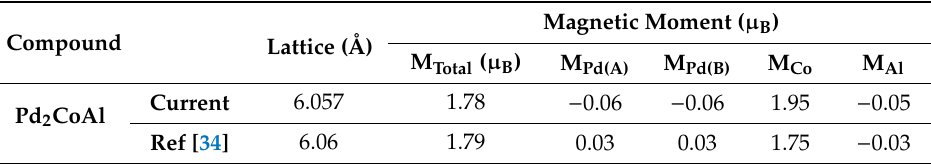
Table 1. The calculated equilibrium lattice constant, total and atom-resolved magnetic